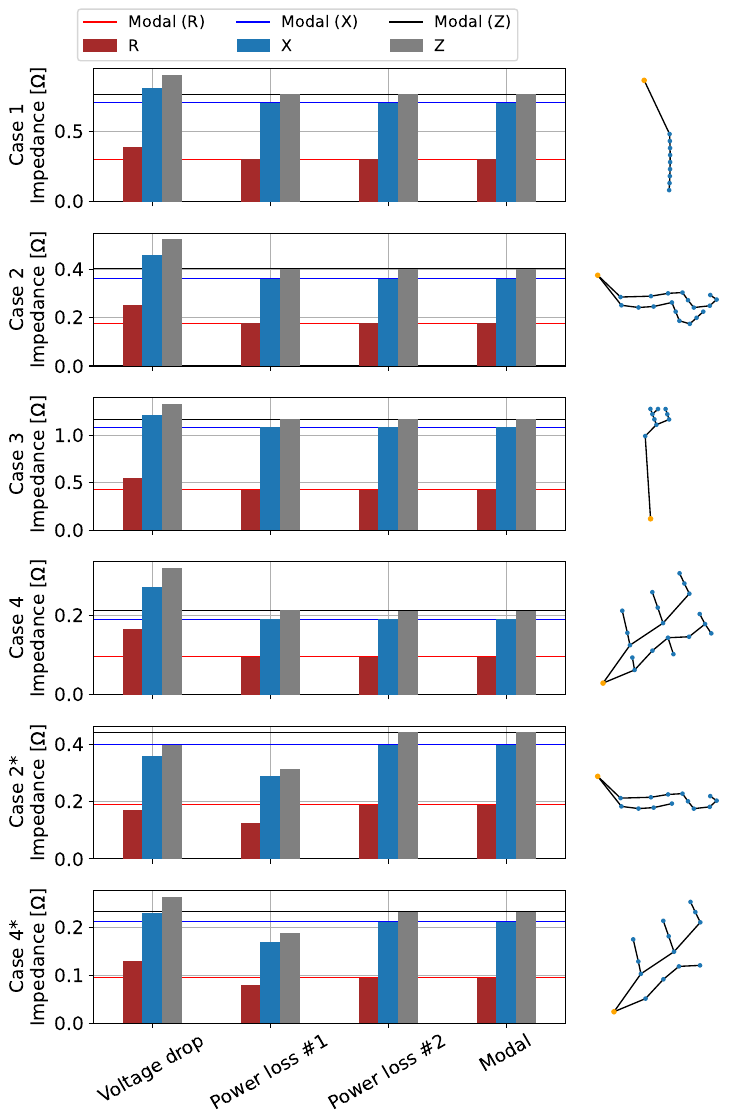
Figure 7. Equivalent impedance calculation and comparison of the investigated aggregation tech- niques to the modal equivalent of Z OSS